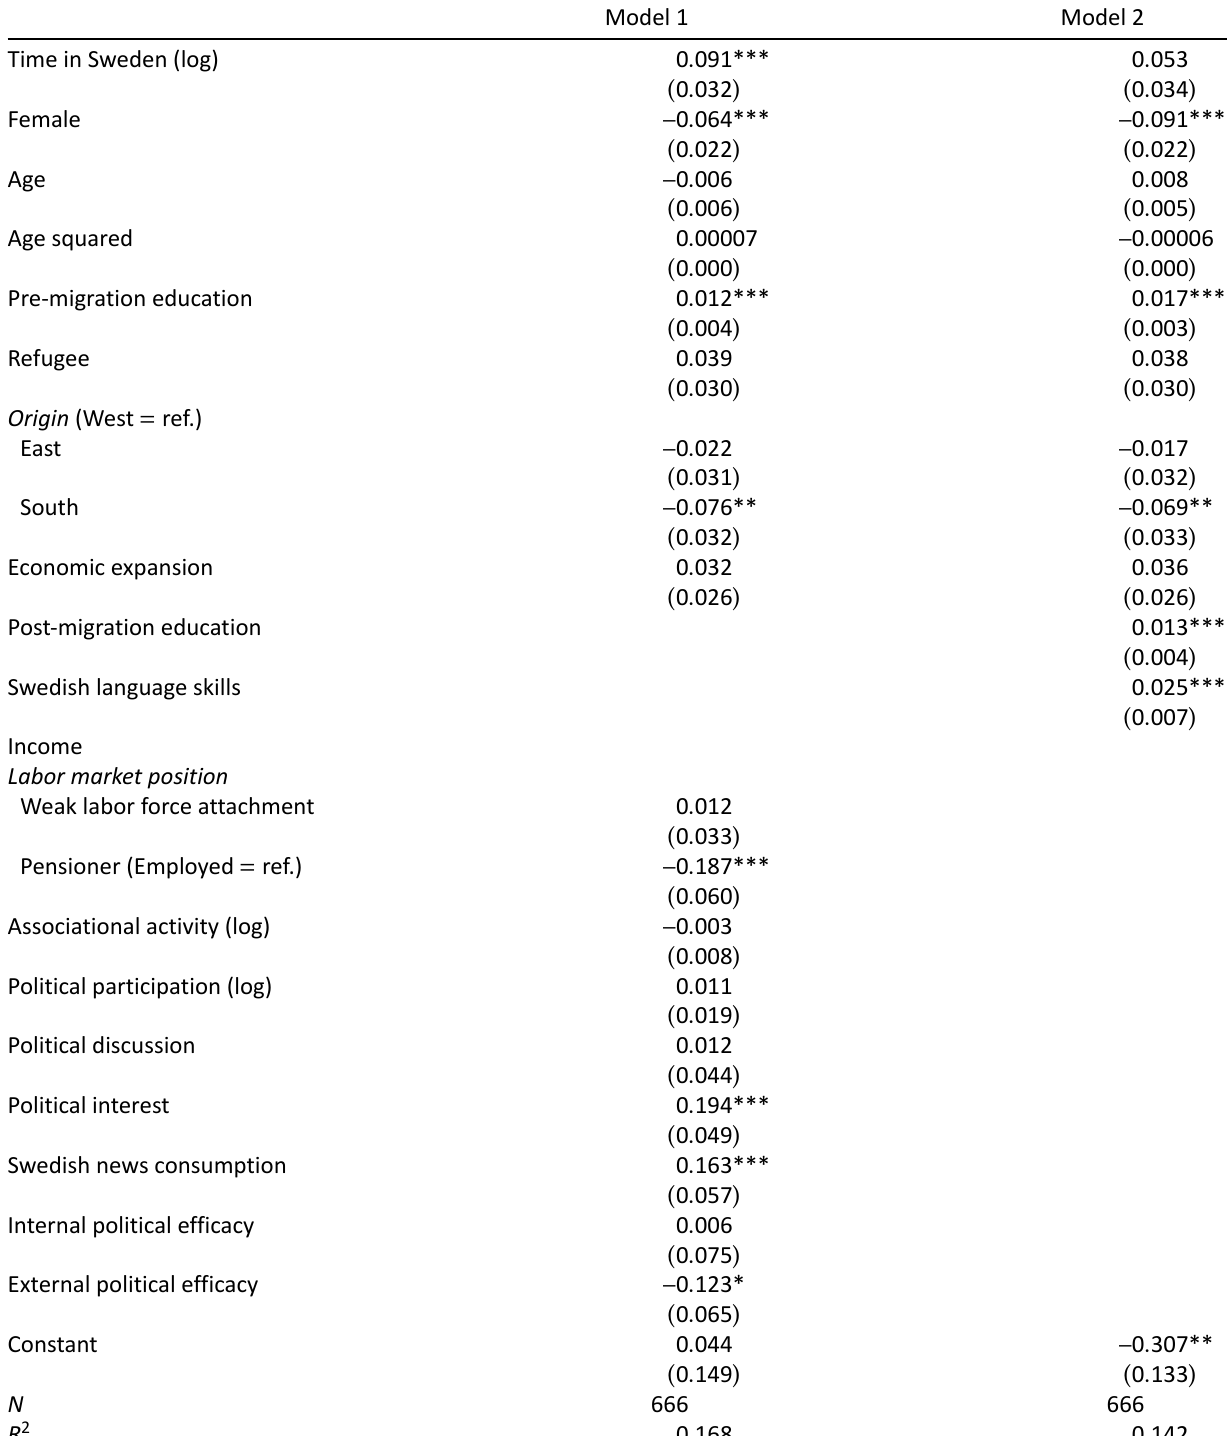
Table A2. Predicting political knowledge (0–1) among immigrants in Sweden, considering time-related differences and ability, motivational, and opportunity